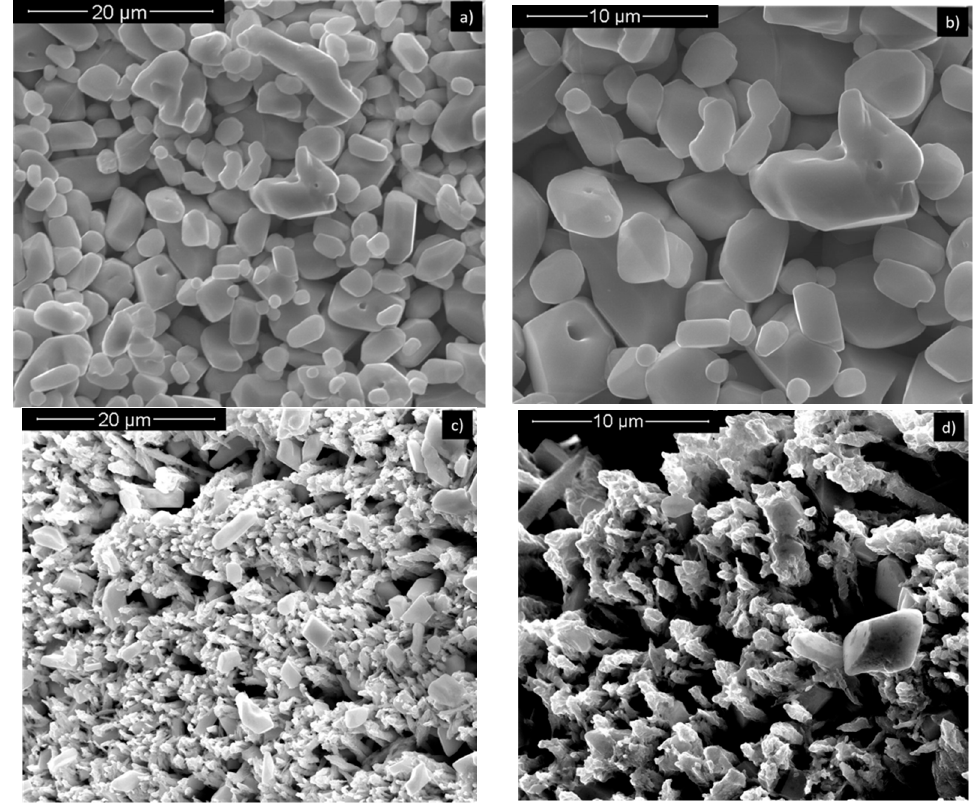
Figure 6. SEM images at different magnifications of Pb and PbO 2 NW electrodes after 1000 cycles at 10 C at the end of the 1000th discharge at 25 ± 2 °C: ( a , b ) Pb electrode and ( c , d ) PbO 2 electrode.